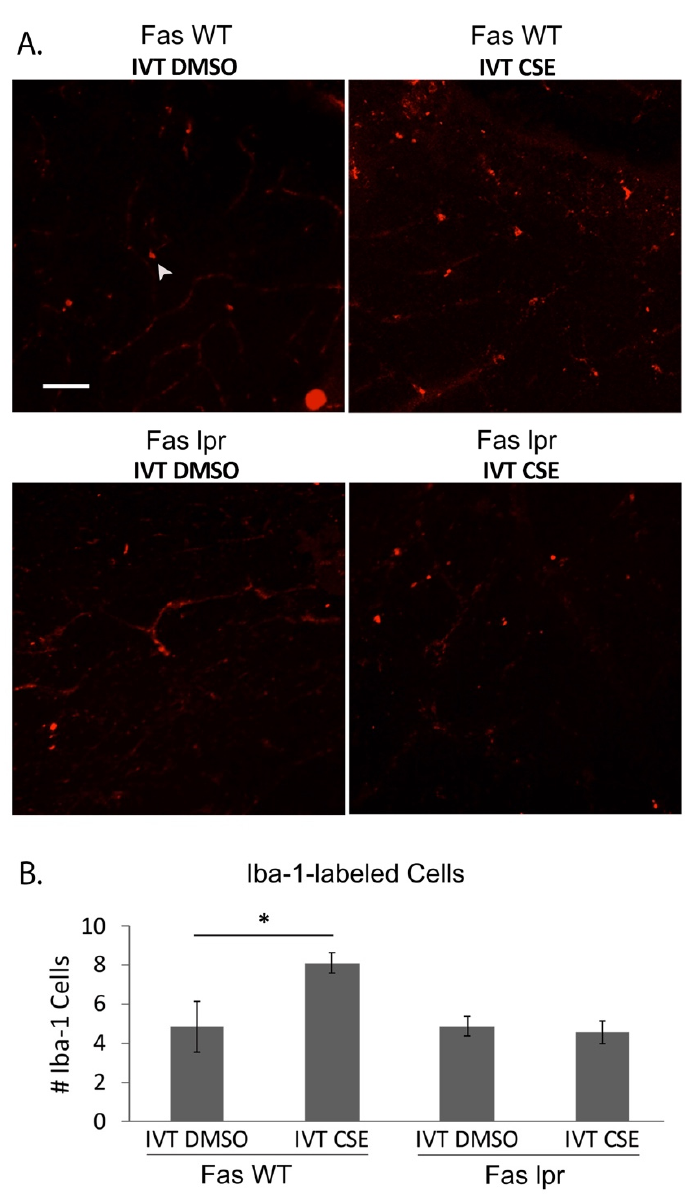
Figure 5. Fas deficiency reduces the inflammatory microenvironment following cigarette smoke extract. Wild-type control (Fas WT) or Fas-deficient lpr (Fas lpr) mice ( n = 5 each) were given intravitreal CSE in one eye or vehicle in the contralateral eye. ( A ) After 10 days, retinal flatmounts were immunolabeled for Iba-1 to identify macrophages and microglia. Compared to control retina ( upper left panel ), the number of Iba-1-labeled cells (arrowhead) were increased after CSE stimulation ( upper right panel ), which was decreased in the retinas of lpr mice given either DMSO vehicle or CSE. Bar = 50 µm. ( B ) Graph quantifies the number of Iba-1-labeled cells in the retinas. * p < 0.05.